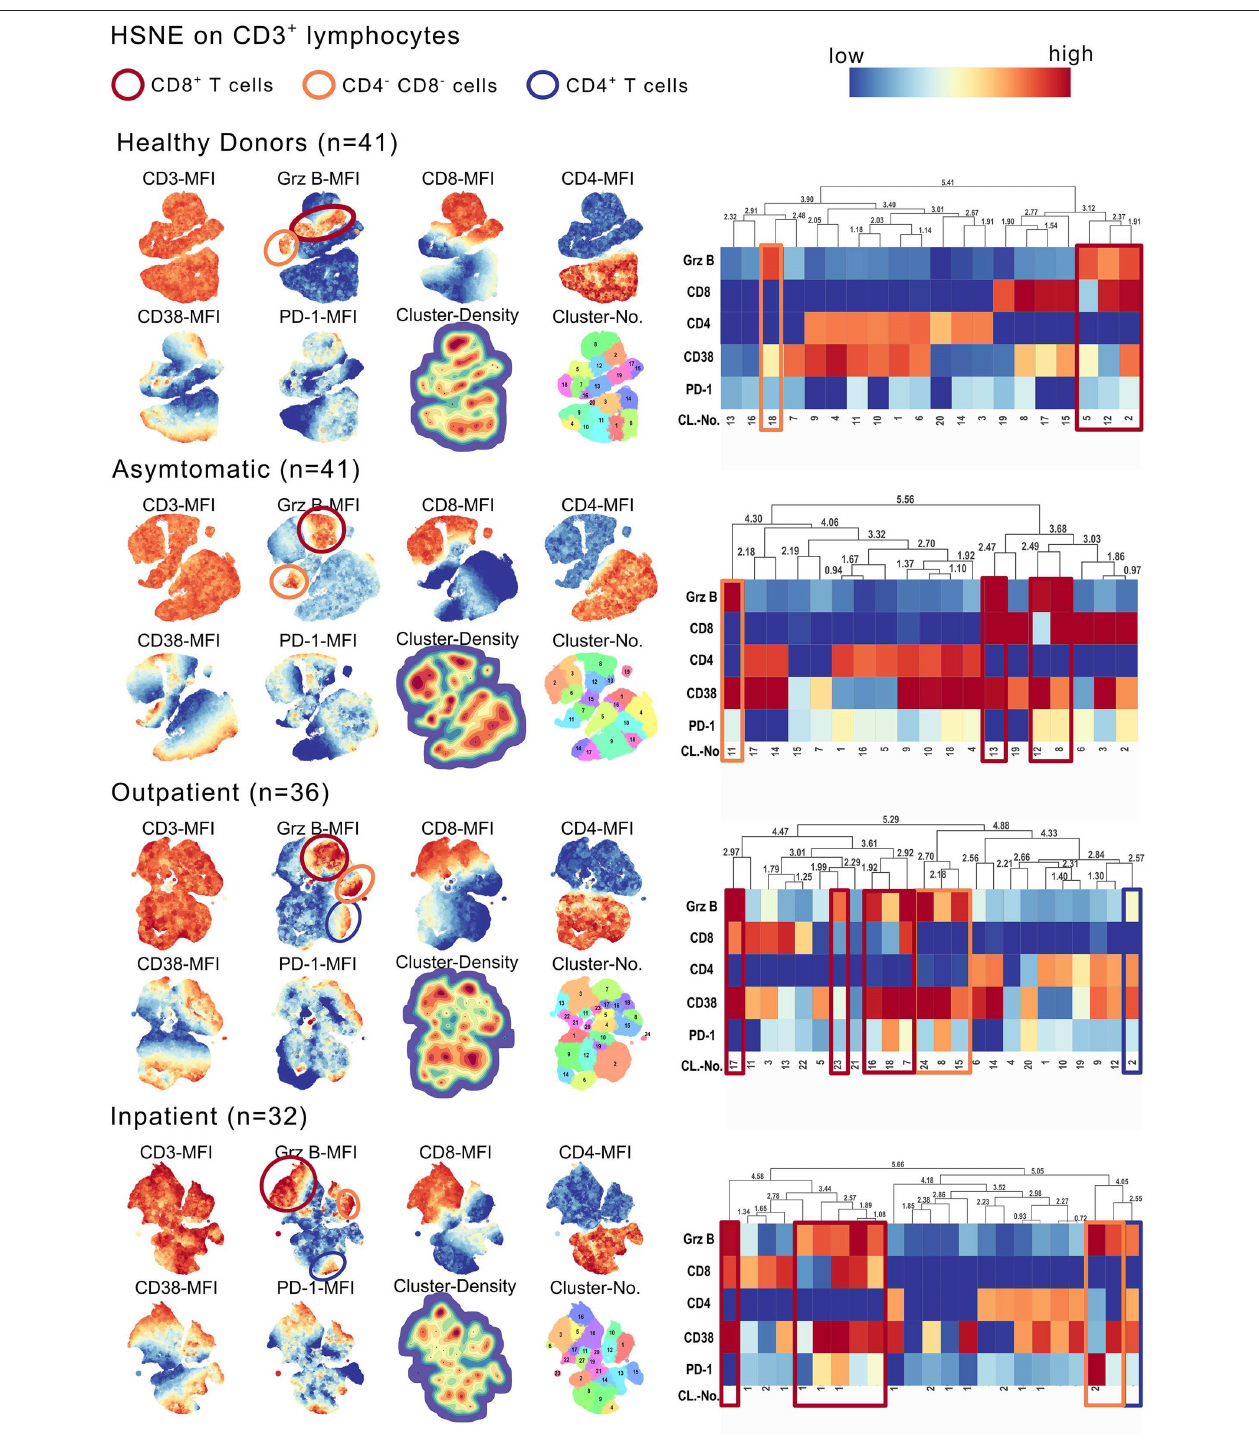
FIGURE 2 | CD3 + CD8 + T cells express high amounts of GrzB in P. falciparum infected children. CD3 + lymphocytes of all study participants were concatenated group wise (HD n = 41; AS n = 41; OP n = 36; IP n = 32). The cell number of all concatenated groups were downsampled to 10 6 cells/group. Hierarchical stochastic neighbor embedding (HSNE) analysis of all groups based on the expression of CD3, CD8, CD4, Granzyme B, CD38, and PD-1 were computed. Landmark development and clustering were complete data-driven. Landmark-based clusters were used for heat map generation. Color code represents mean fluorescence intensity (red = high; blue = low). Blue boxes indicate GrzB-producing CD4 + T cell subsets, red boxes indicate GrzB-producing CD8 + T cells. Orange boxes highlight CD3 + CD4 − CD8 − T cell subsets, producing GrzB.